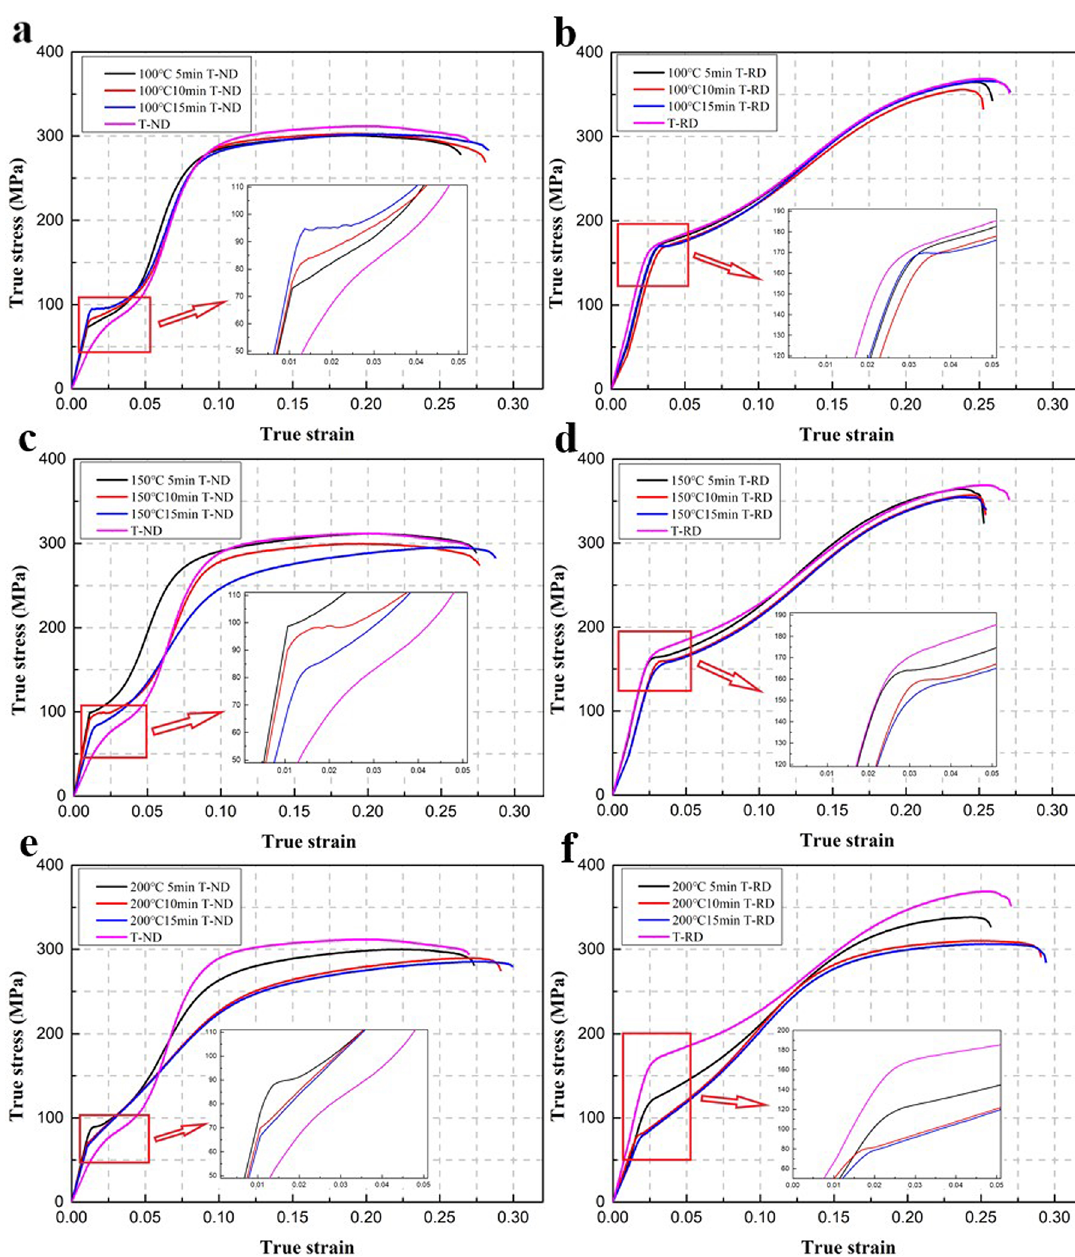
Figure 6. True stress–strain curves of specimens after